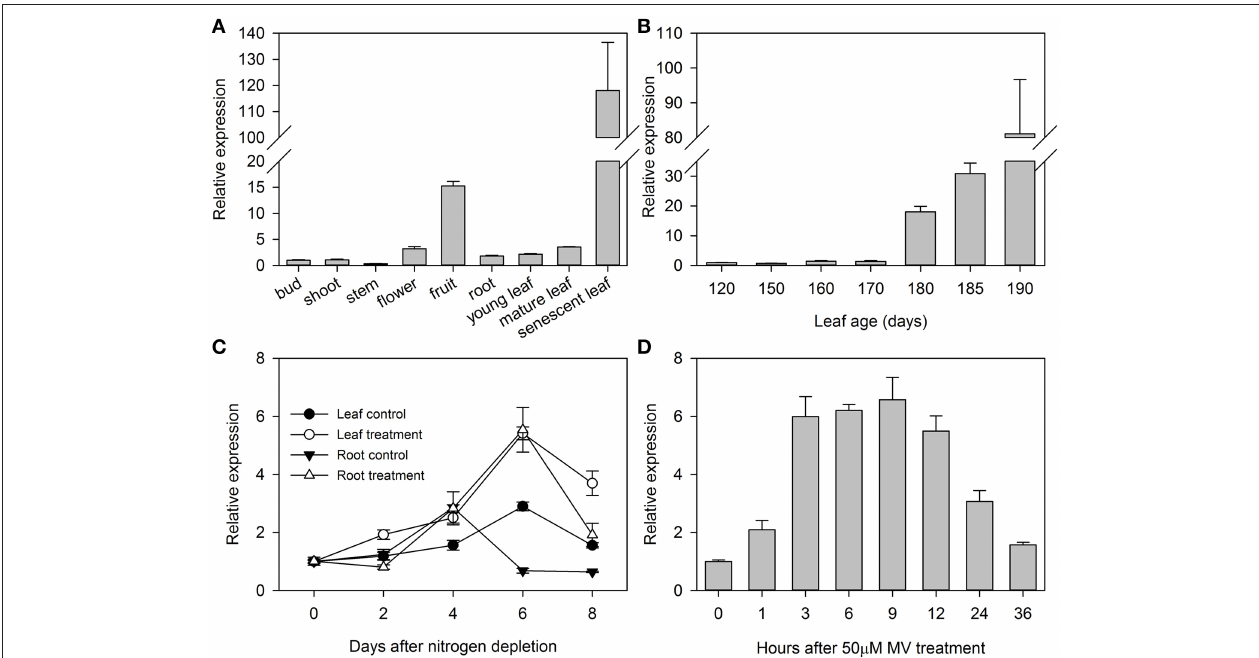
FIGURE 2 | Expression profiles for MdATG8i in different tissues (A), during leaf senescence (B), under nitrogen-starvation (C), and under MV-induced oxidative stress (D). Total mRNA was extracted from samples and qRT-PCR was performed with gene-specific primers. Expression levels were calculated relative to expression of Malus EF-1 α mRNA. Data are means ± SD of three replicate samples.